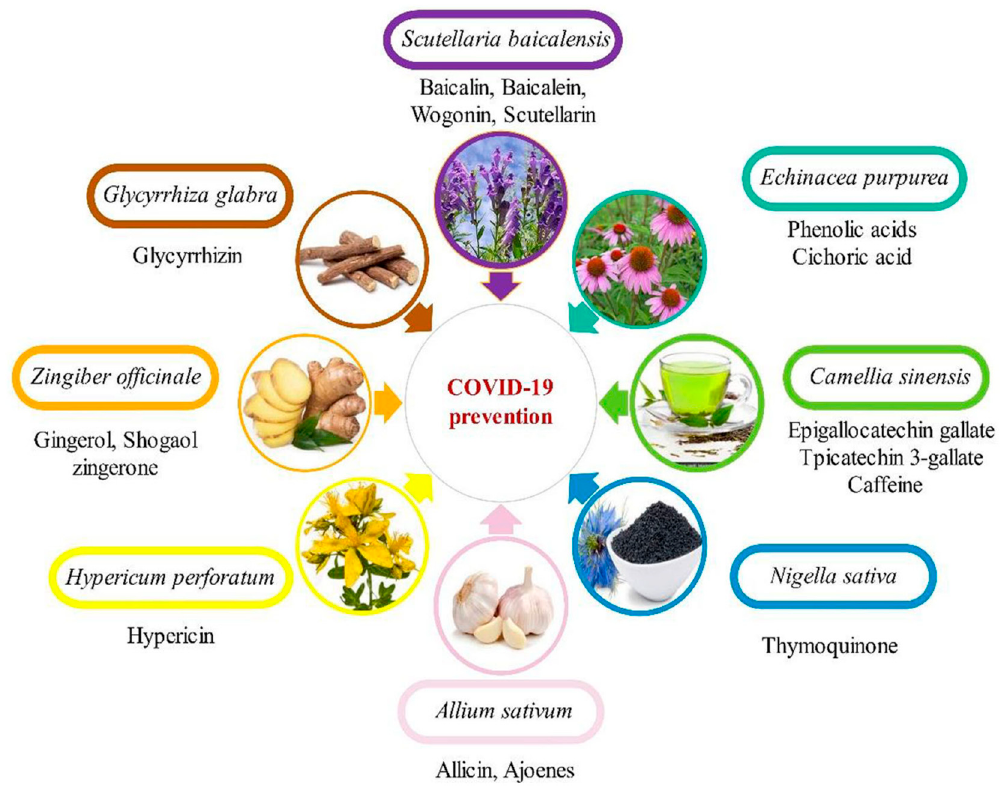
Figure 2. Some natural plant products for precluding SARS-CoV-2 infection (Reproduced from